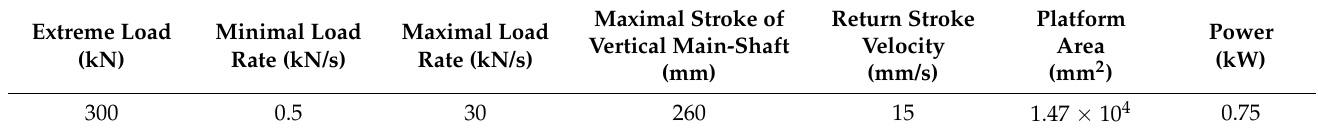
Table 1. Uniaxial compression system parameters.